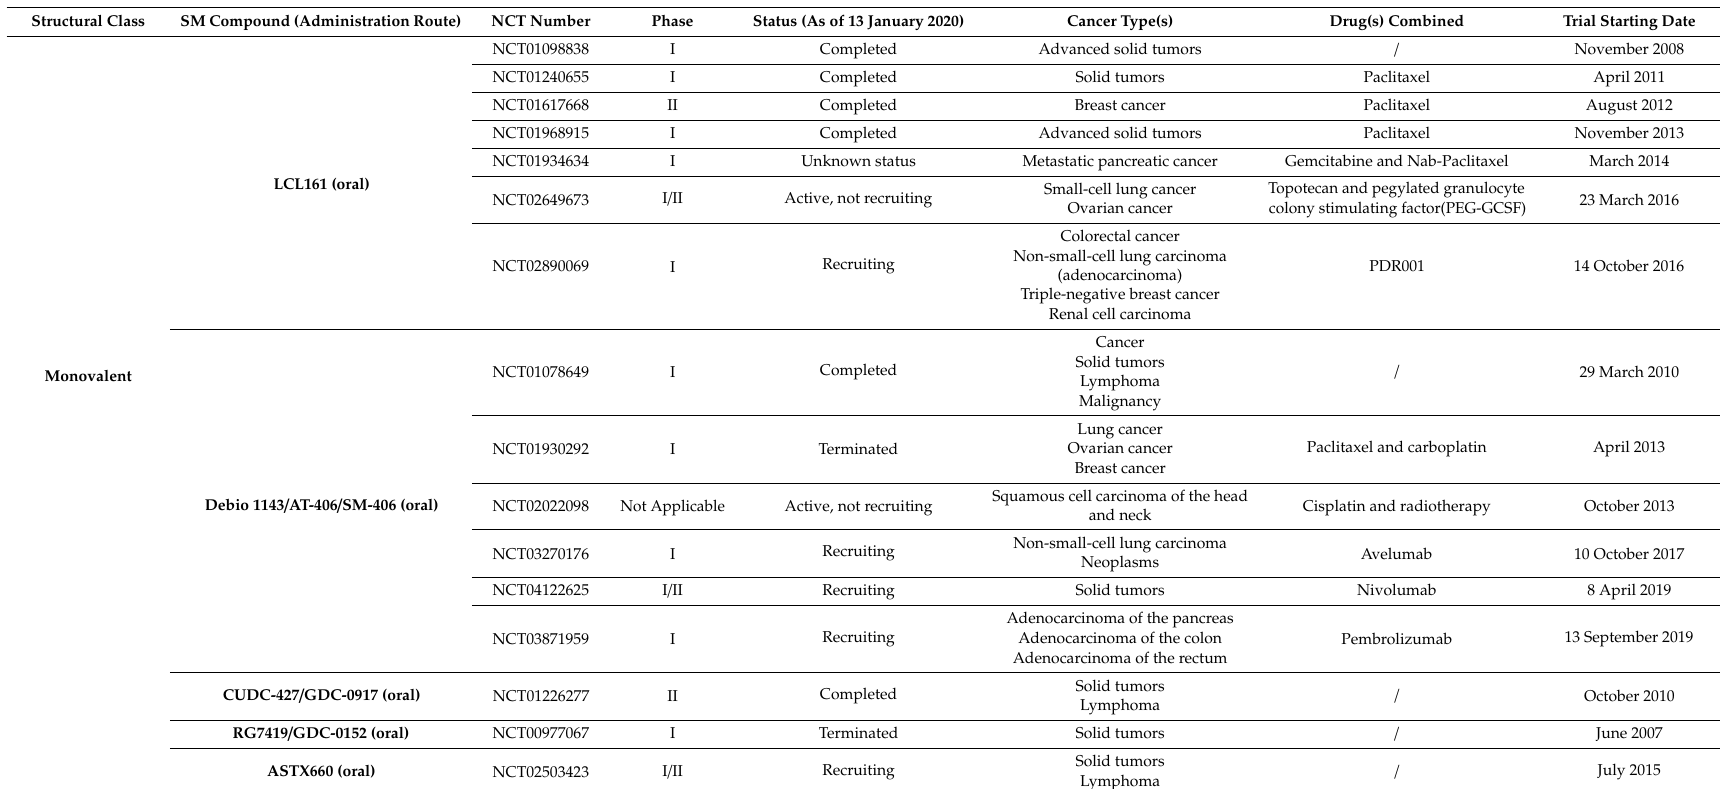
Table 1. SMs in completed or ongoing clinical